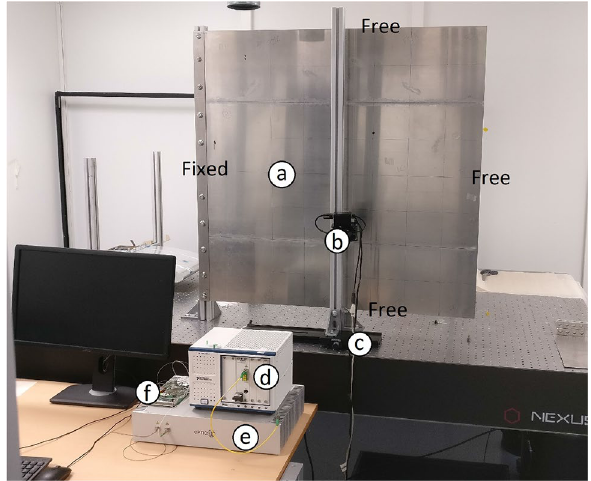
Fig. 6 Laboratory setup of the experimental study containing the a cantilever plate, b linear displacement stage actuator, c slider setup for the linear actuator, d National Instruments interrogator, e optics11 interrogator and the f Thorlabs optical switch is displayed